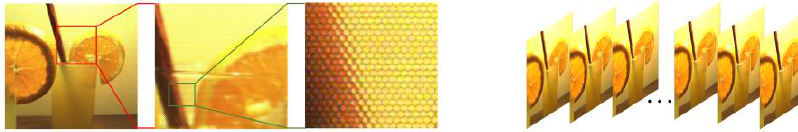
Fig. 4. The acquired light field image Fig. 5. Multi focus image source set based on light field image.